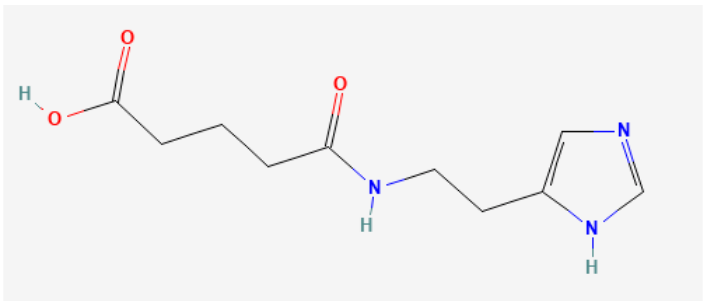
Figure 9. Chemical structure of IEPA (source: https://pubchem.ncbi.nlm.nih.gov/ (accessed on 6 February 2023)).